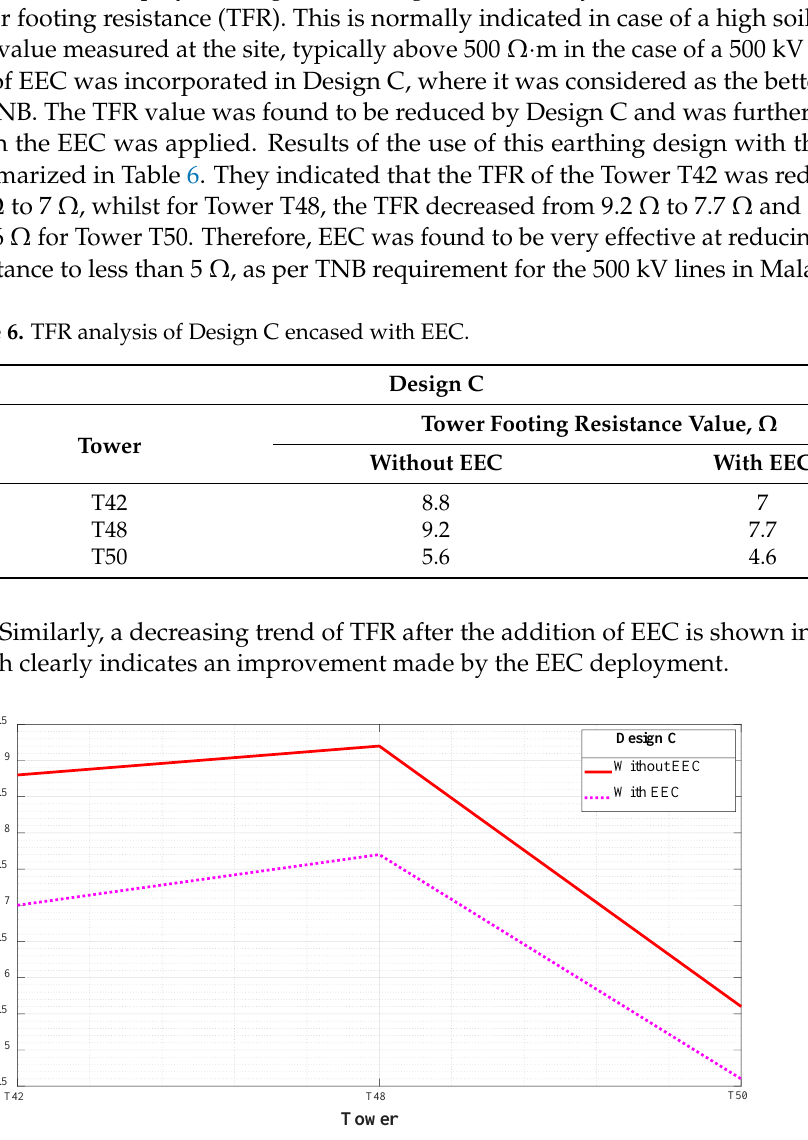
Table 7. Percentage reduction of TFR for selected towers.